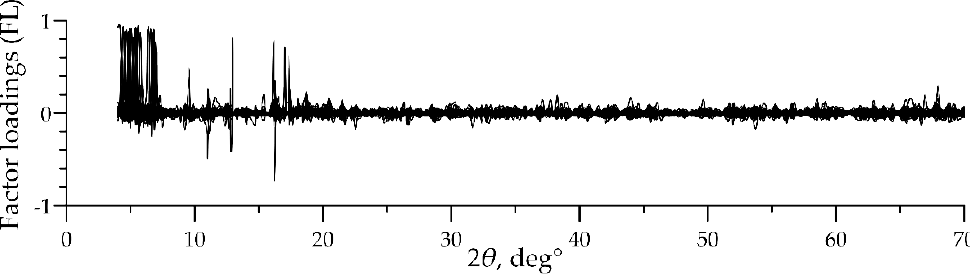
Figure 3. The factor loadings ( FL) graphs of the noise factors (42 out of 107 factors). Figure 3 is taken from [35].